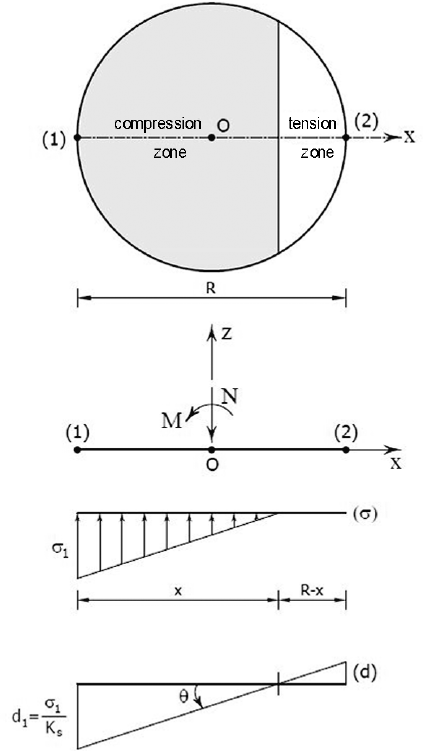
Fig. 2. Soil pressure distribution and displacement profile of